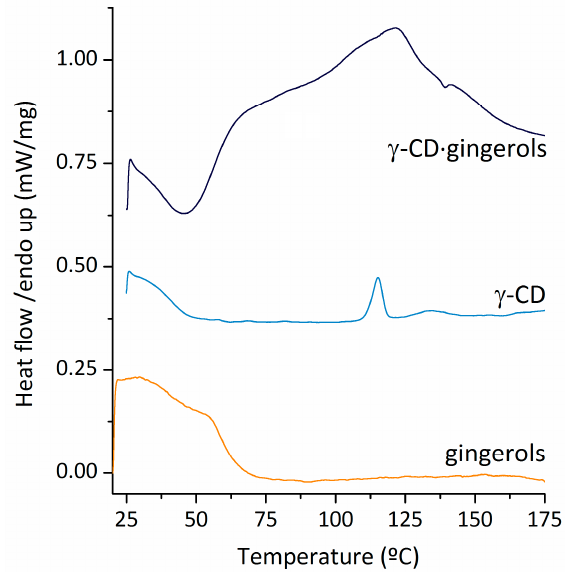
Figure 4. Di ff erential scanning calorimetry traces of gingerols ( bottom ), pure γ -CD heptahydrate Figure 4. Differential scanning calorimetry traces of gingerols (bottom), pure γ -CD heptahydrate ( middle ) and γ -CD · gingerols ( top (middle) and γ -CD·gingerols (top).